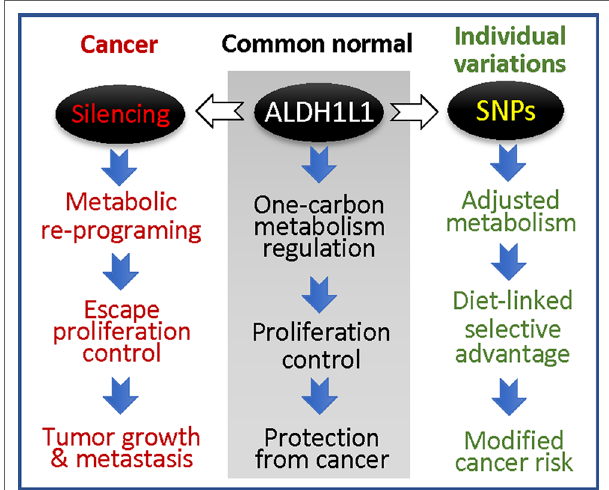
FiGURe 6 | ALDH1L1 is a main regulator of folate metabolism, and its gene is commonly silenced in cancer (the loss of the protein is linked to accelerated proliferation and tumor progression); coding SNPs in this gene are likely to modify cancer